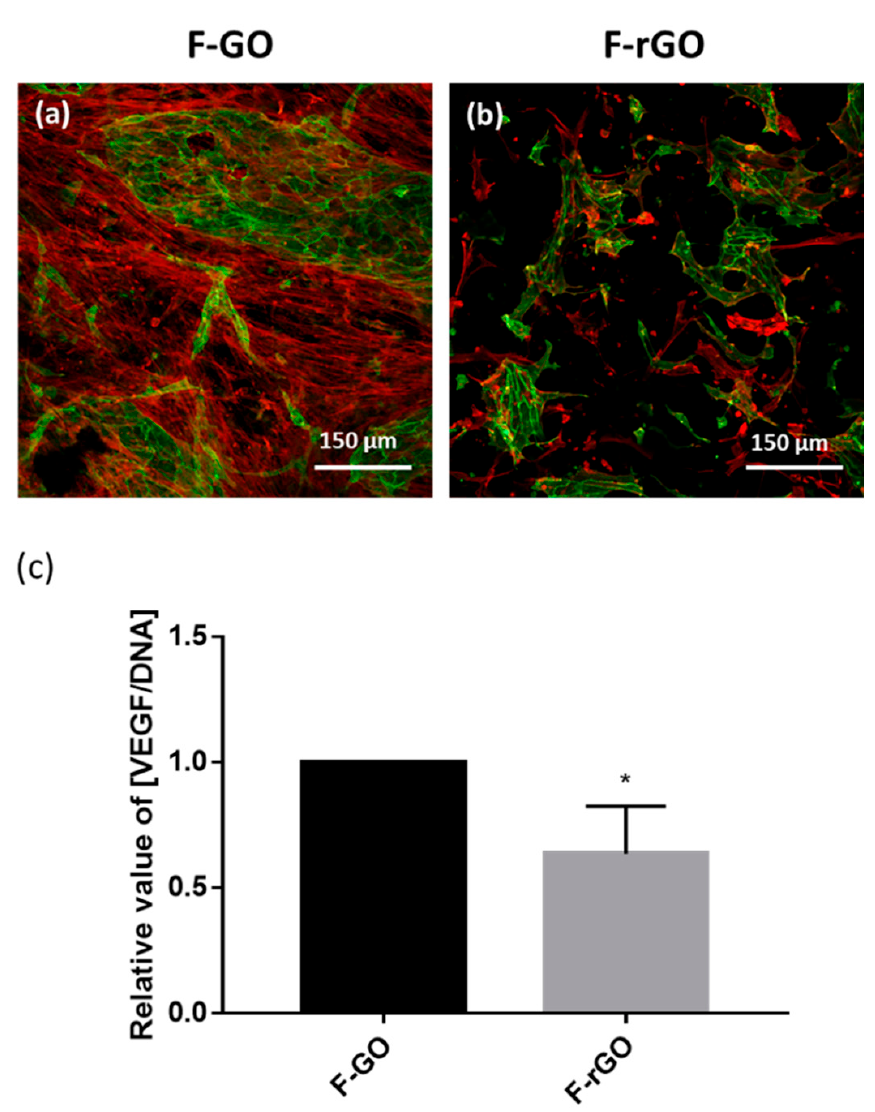
Figure 3. Impact of F-GO and F-rGO on vascularization processes. ( a , b ) MSC/OEC co-cultures on F-GO and F-rGO on day 7, visualized by CLSM. Cells were stained with VE-Cadherin (green), Phalloidin-TRITC (red) and Höchst (blue). The scale bars represent 150 µ m. ( c ) The relative level of VEGF in the supernatant of MSC/OEC co-cultures on F-GO or F-rGO on day 7, measured with enzyme-linked immunosorbent assay. VEGF levels were normalized to DNA content and depicted in relation to F-GO (as control). t -test, * p < 0.05, n = 3 Donor